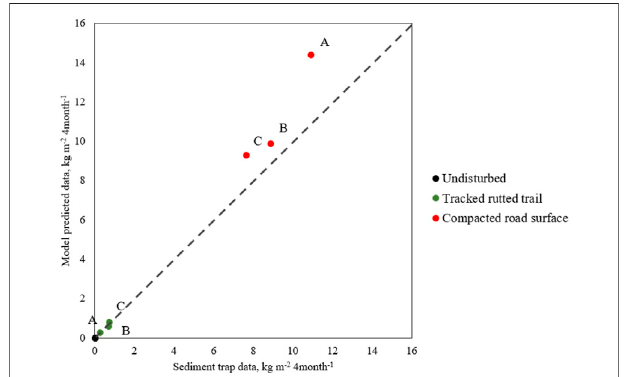
FIGURE8| Linear relationship between theactual measured databysilt fences and WEPP modeled data. The dashed line represents a 1:1 relationship.